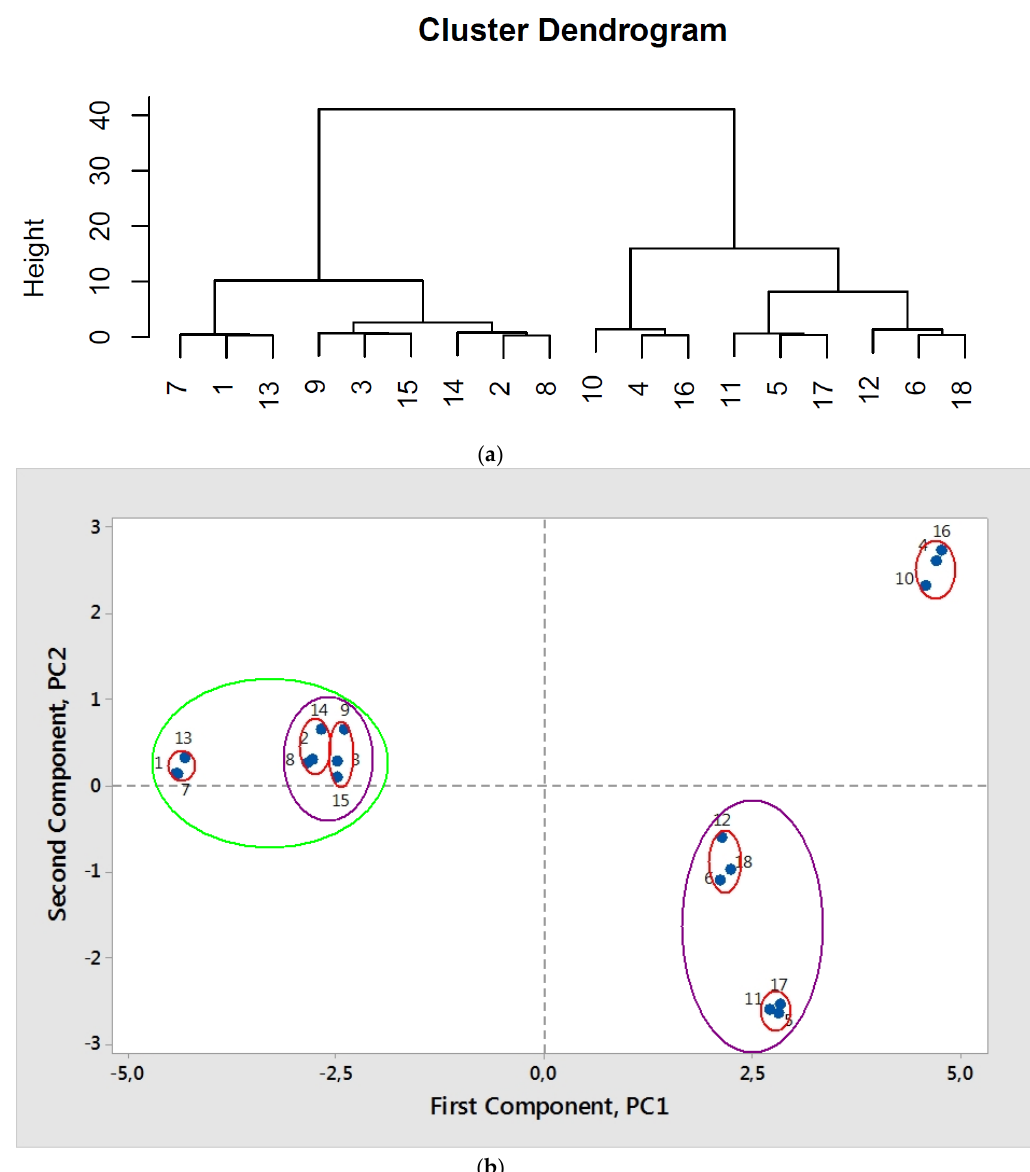
Figure 7. ( a ) Cluster dendrogram for different biomasses based on criteria for correlation matrix analyzed for data repeated in triplicates. ( b ) Principal component analysis and defined groups according to parameters presented in Figure 6. First series: 1—EW(1); 2—B(1); 3—EP(1); 4—MG(1); 5—CC(1) and 6—TP(1); second series: 7—EW(2); 8—B(2); 9—EP(2); 10—MG(2); 11—CC(2) and 12—TP(2) and third series: 13—EW(3); 14—B(3); 15—EP(3); 16—MG(3); 17—CC(3) and 18—TP(3).